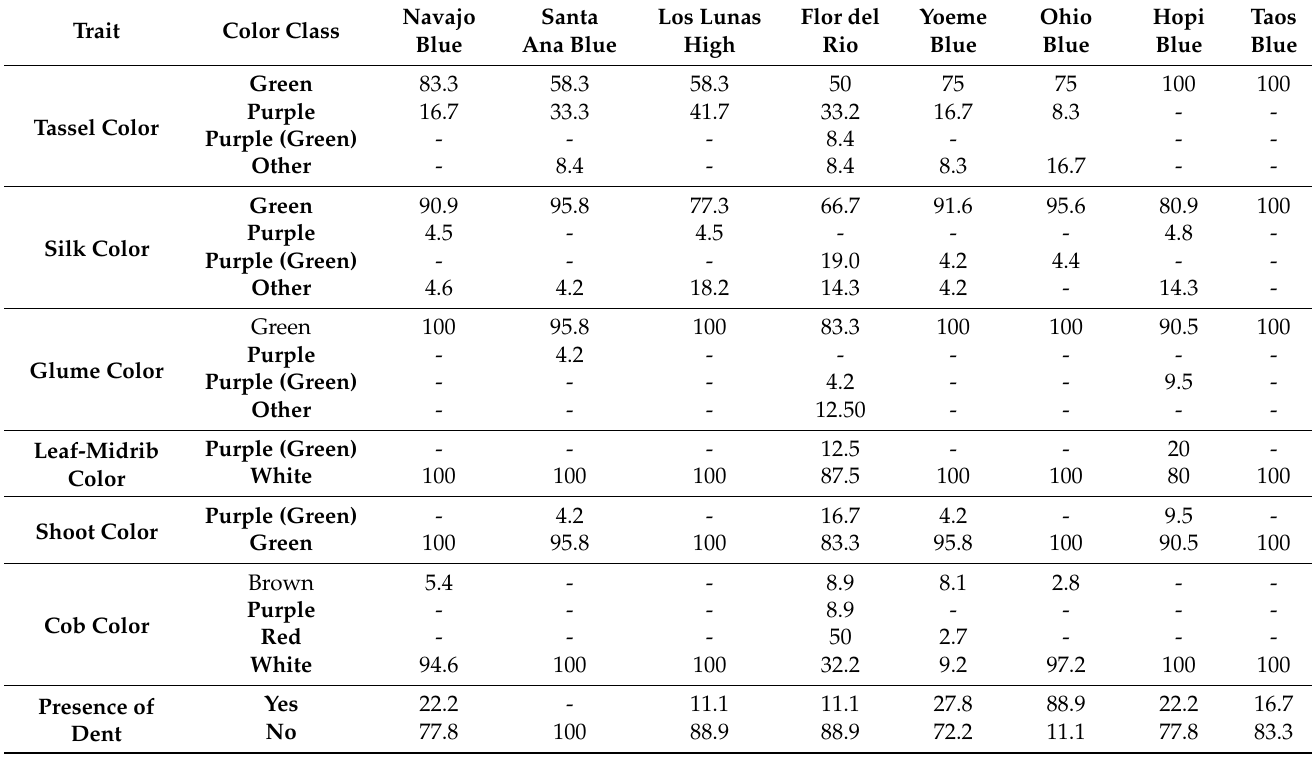
Table 2. Relative proportion of different color classes for morphological traits and presence of kernel color phenotype among different blue corn landraces.